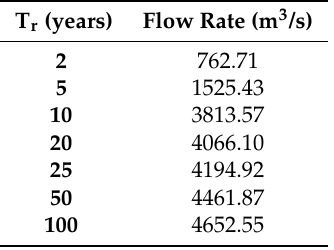
Table 1. Dripping flow rates for different return periods T r